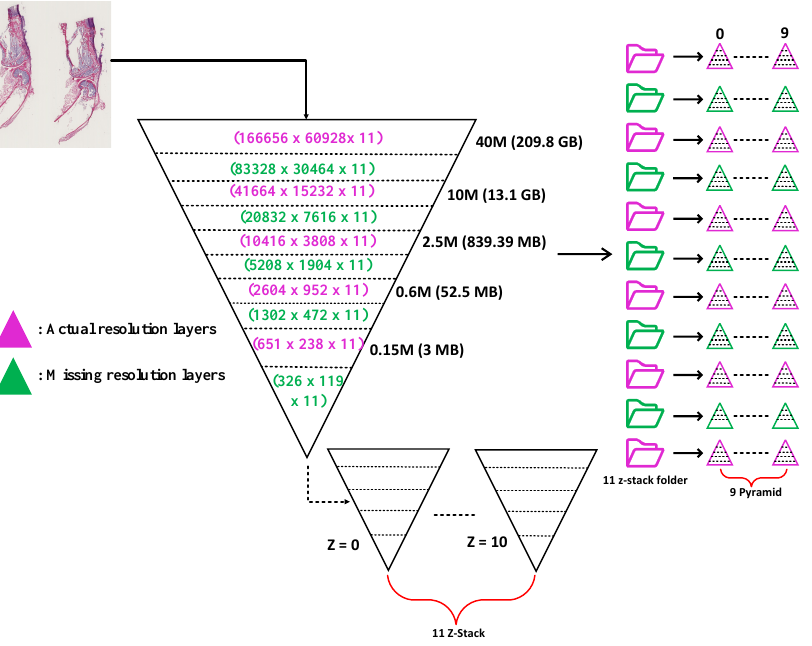
Figure 11. Eleven stack WSI images (belongs to .ndpi extension) successfully converted into stan- dard